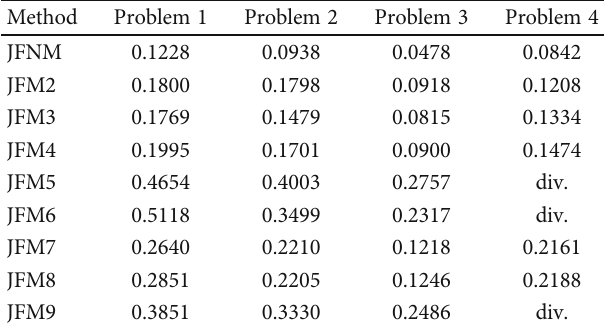
Table 5: Values of JFC1 for case n = 25 .